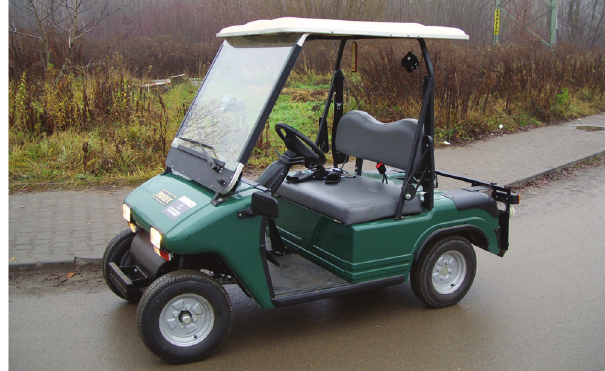
Fig. 1. Electric light commercial vehicle Melex 945DS